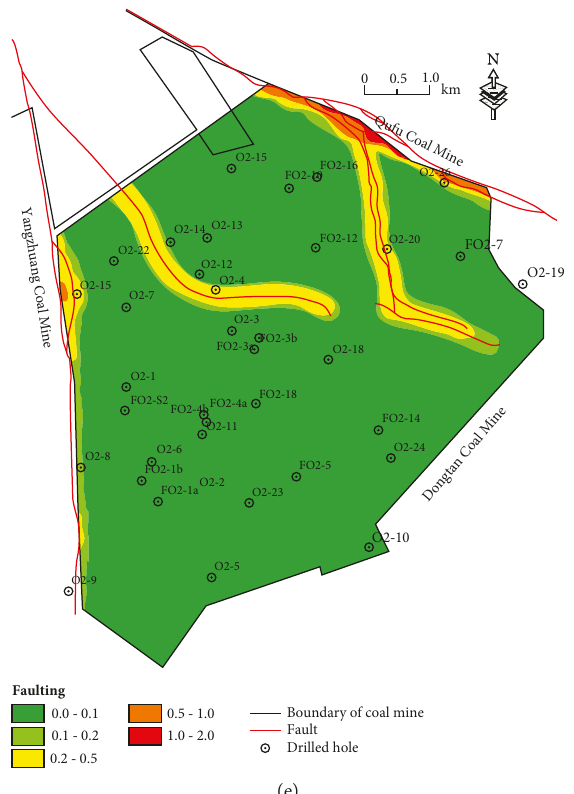
Figure 6: Maps of evaluation factors: (a) interbedded mudstone thickness ratio; (b) relative argillaceous content; (c) RQD; (d) impermeable fi lling zone thickness; (e)